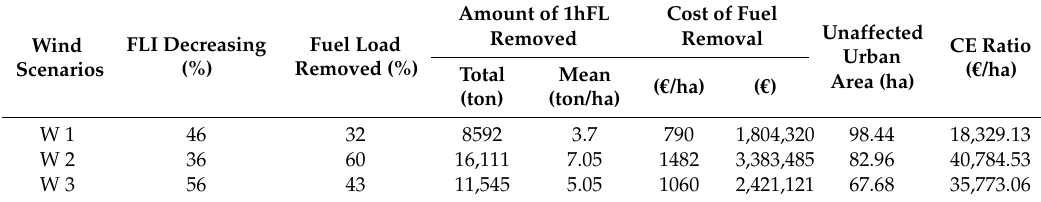
Table 4. Cost-effectiveness analysis of fuel load